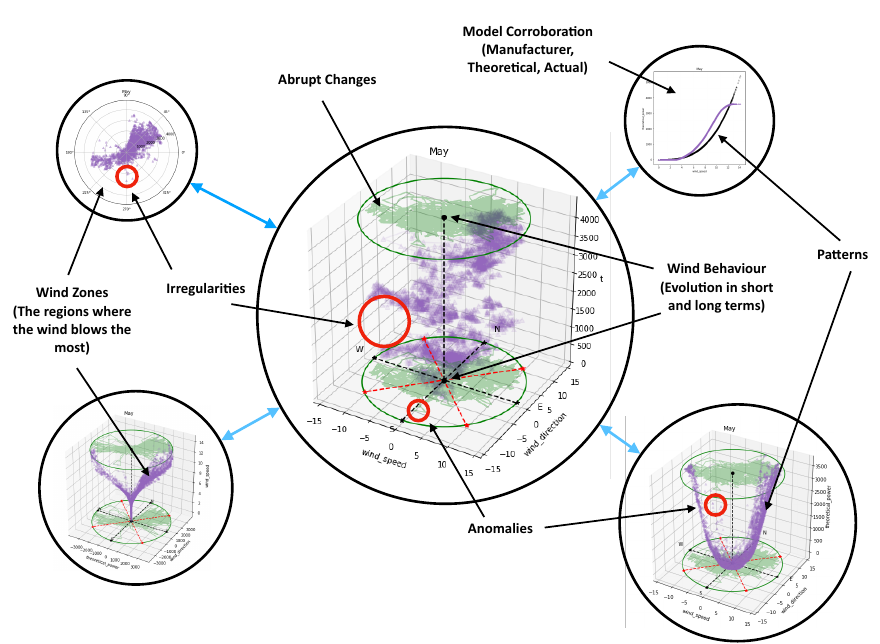
Figure 3. The one month data visualization in cylindrical coordinates with possible analysis.